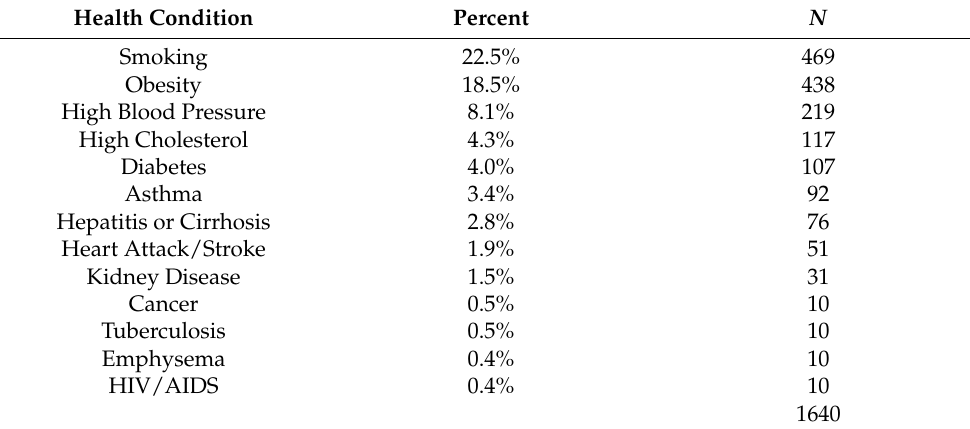
Table 4. Disease Prevalence among Hispanics Experiencing Homelessness.